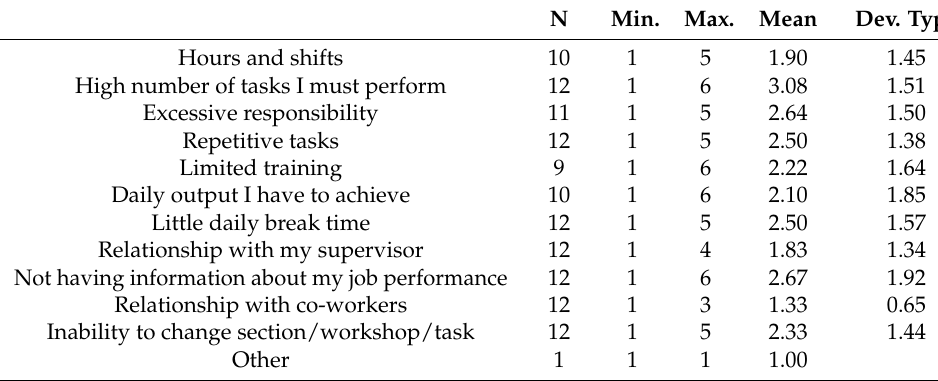
Table 13. Descriptive statistics of stress intensity rating.